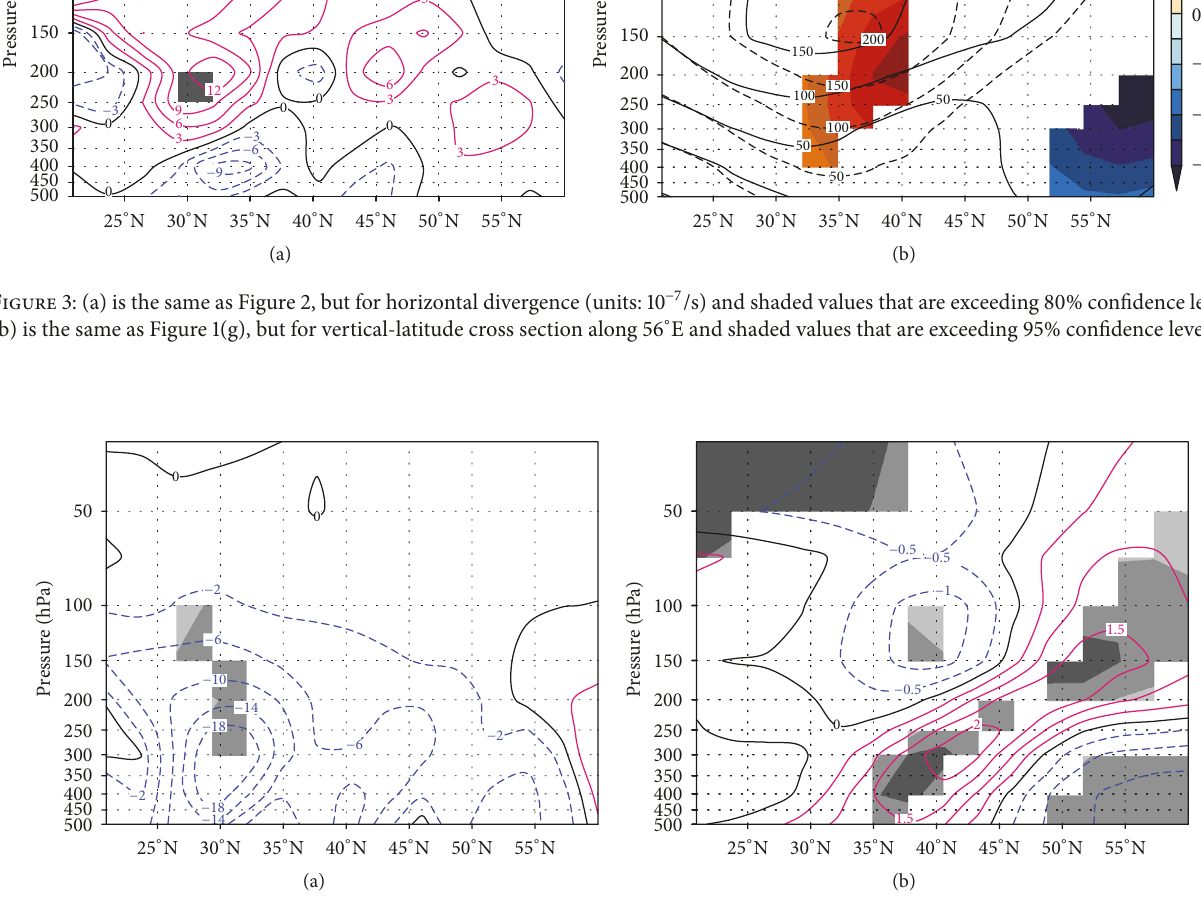
in the north of the center of SAH, and the difference between two experiments satisfies the significance test at the 90% confidence level (Figure